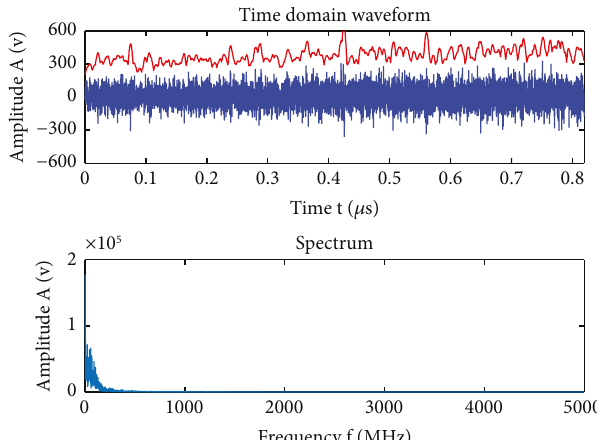
Figure 7: Adaptive multiscale morphological gradient (AMMG) signals and spectrum.